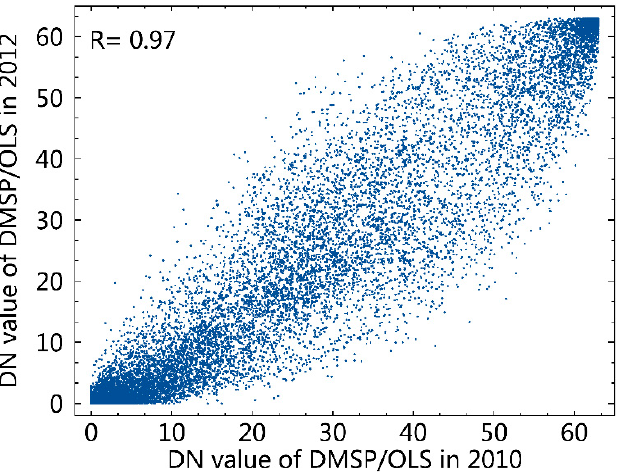
Figure 2. Scatter plot between the DN values of Defense Meteorological Satellite Program/ Operational Line Scanner DMSP/OLS Night-time light (NTL) in 2010 and 2012 in